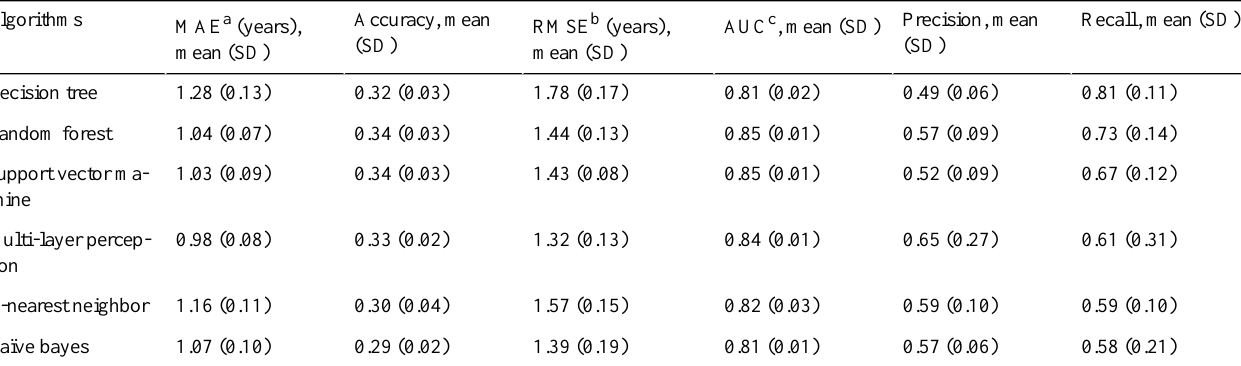
Table 10. Mean (SD) of the performance metrics for the male subjects’classification models.